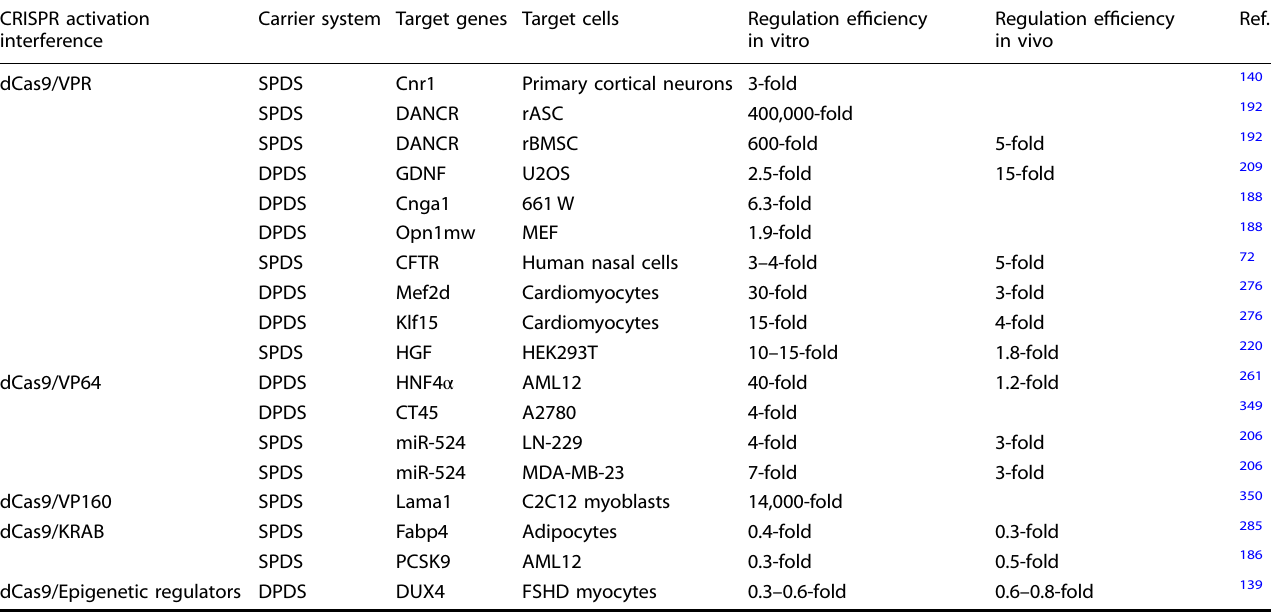
Table 4. Ef fi ciency of CRISPRa- and CRISPRi-mediated activation and inhibition of different genes CRISPR activation